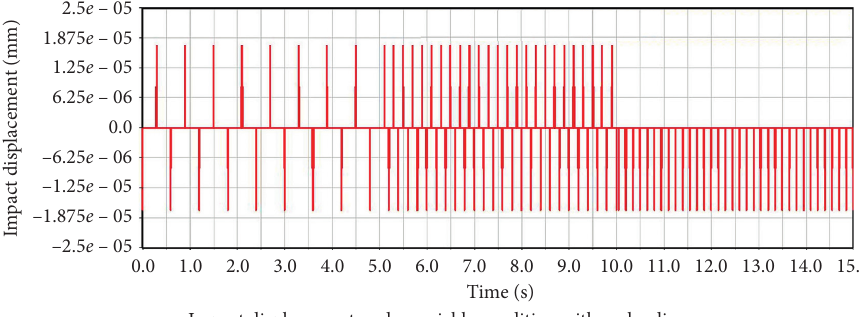
Figure 17: Impact elastic displacement of multistage face gear pair under variable speed with no